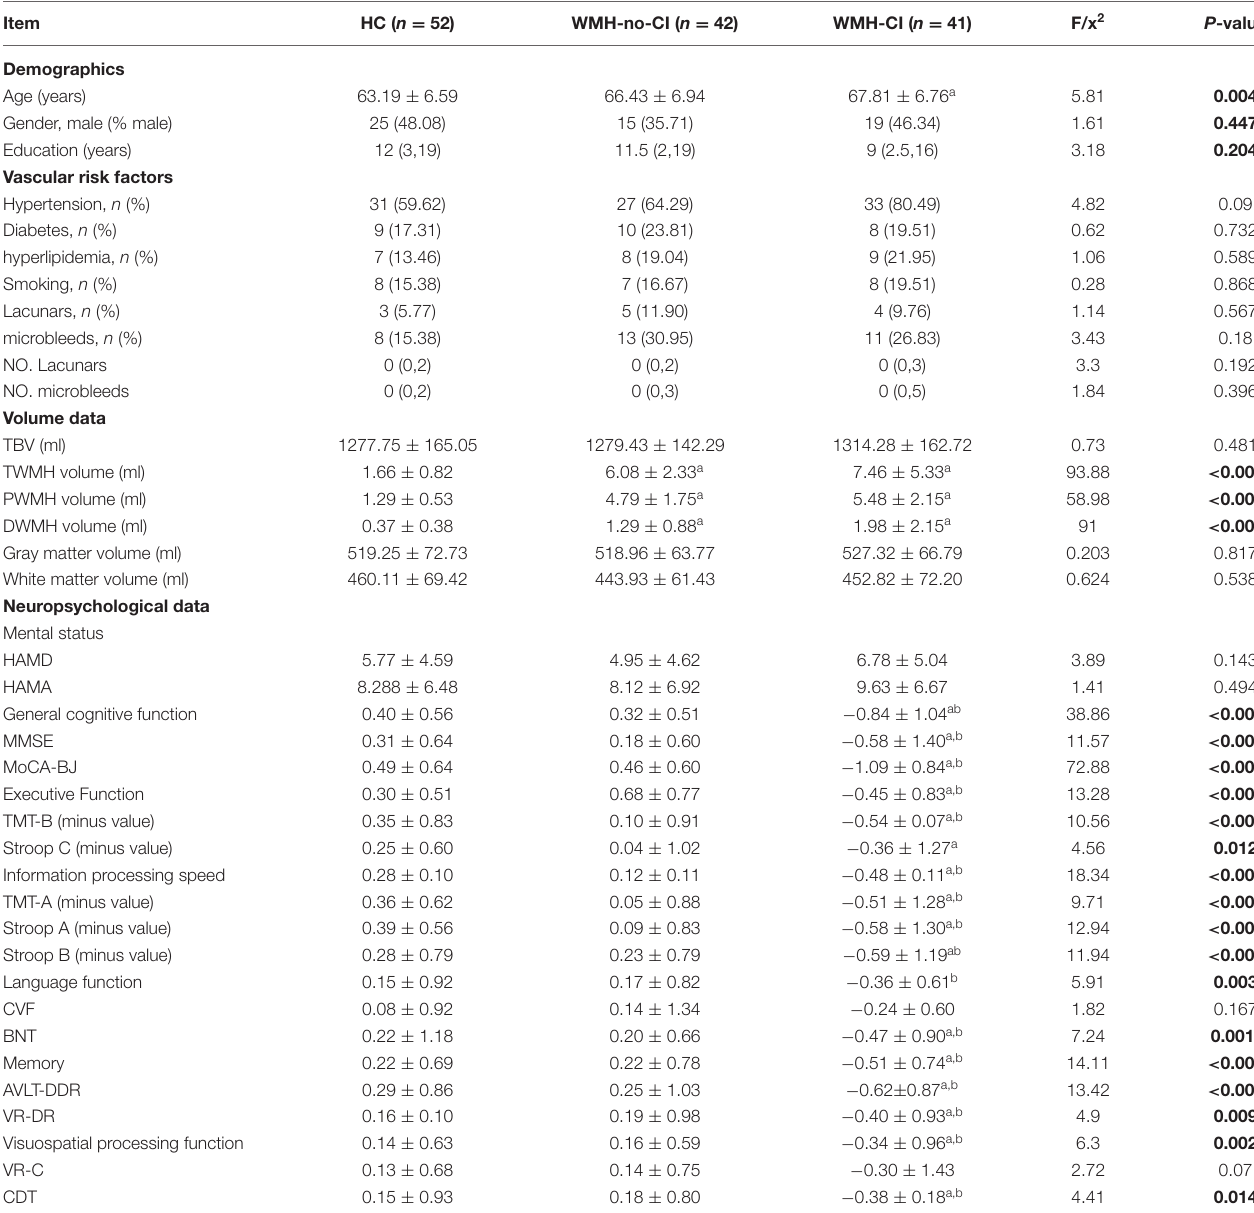
TABLE 1 | Demographic, clinical, volume, and neuropsychological